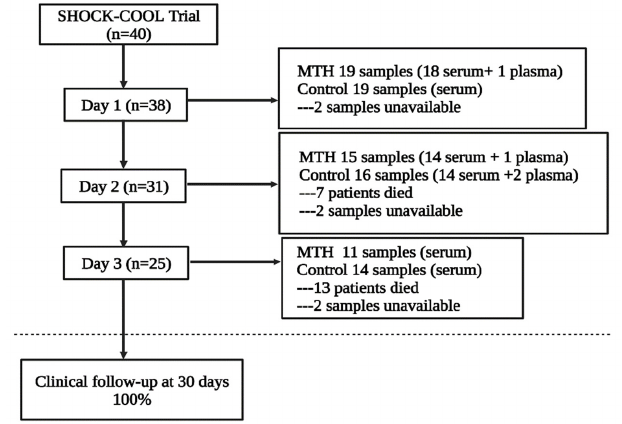
Figure 1. Study flow. SHOCK-COOL, the randomized trial of mild hypothermia for cardiogenic shock. MTH, mild therapeutic hypothermia. Table 1. Demographic and clinical characteristics of patients during three days of hospitalization.